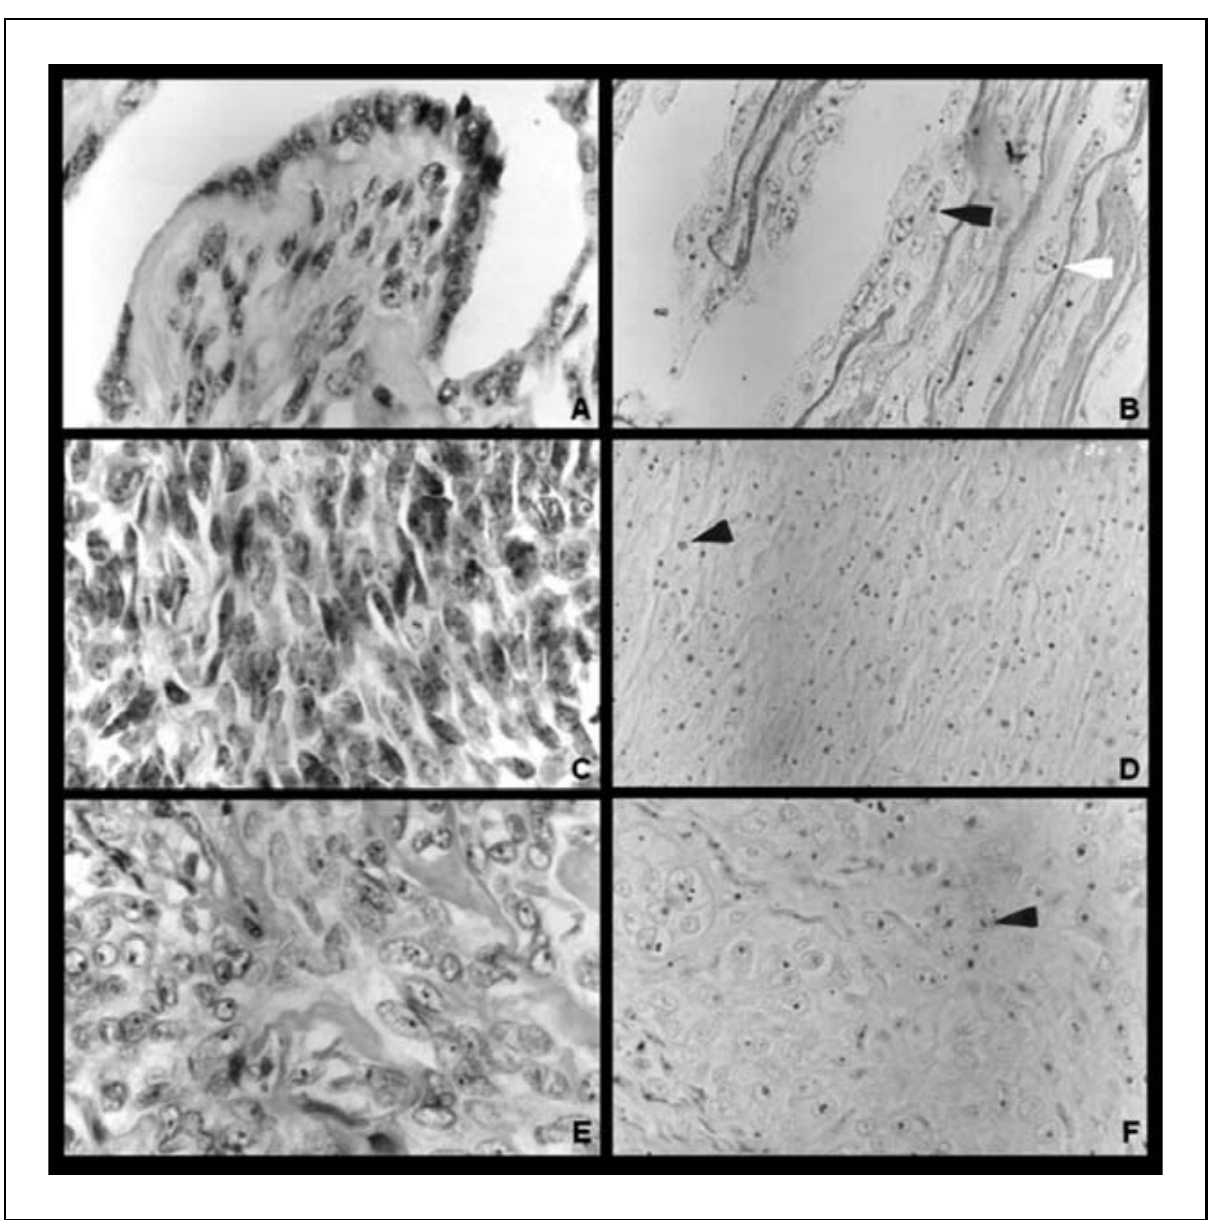
Figura 1 – A fotomicrografia da figura 1A mostra um sarcoma sinovial com elemento epitelióide com aspecto papilífero, corado pela hematoxilina-eosina, e na figura 1B o mesmo sarcoma sinovial corado pela prata. Podemos observar o AgNOR intranuclear castanho e deposição inespecífica da prata. Na figura 1C observamos o sarcoma sinovial com elemento mesenquimal fusocelular, HE, e na figura 1D, agregados intranucleares de AgNOR passíveis de individualização no elemento mesenquimal fusocelular. A figura 1E apresenta um sarcomasinovial com elemento epitelióide sólido, HE, e a figura 1F AgNOR intranuclear no elemento epitelióide